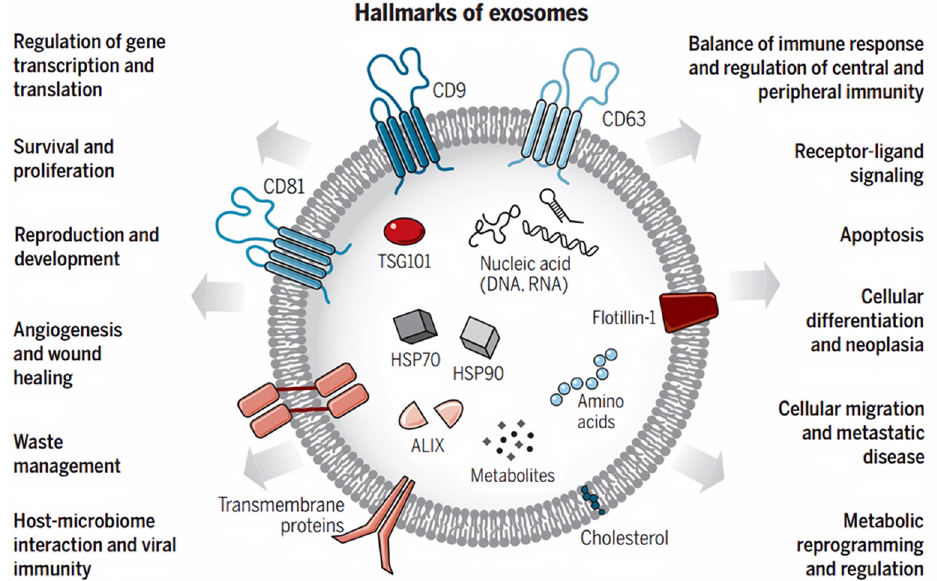
Figure 3. The proteins, lipids, and RNAs that exosomes bear and that have great impact on exosomes’ cellular communication and other functions [45]. Figure reproduced with permission from Science.